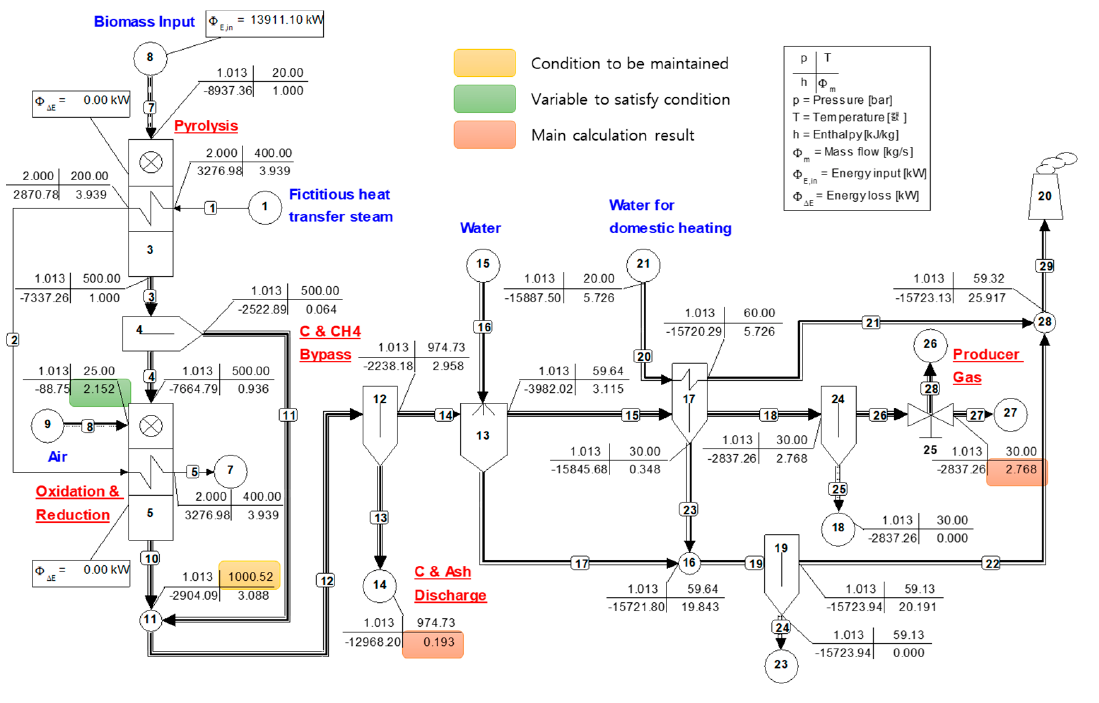
Figure 4. A sample of parametric study of increasing CDR at two ‐ reactor model using rice husk as fuel and CDR 5%.